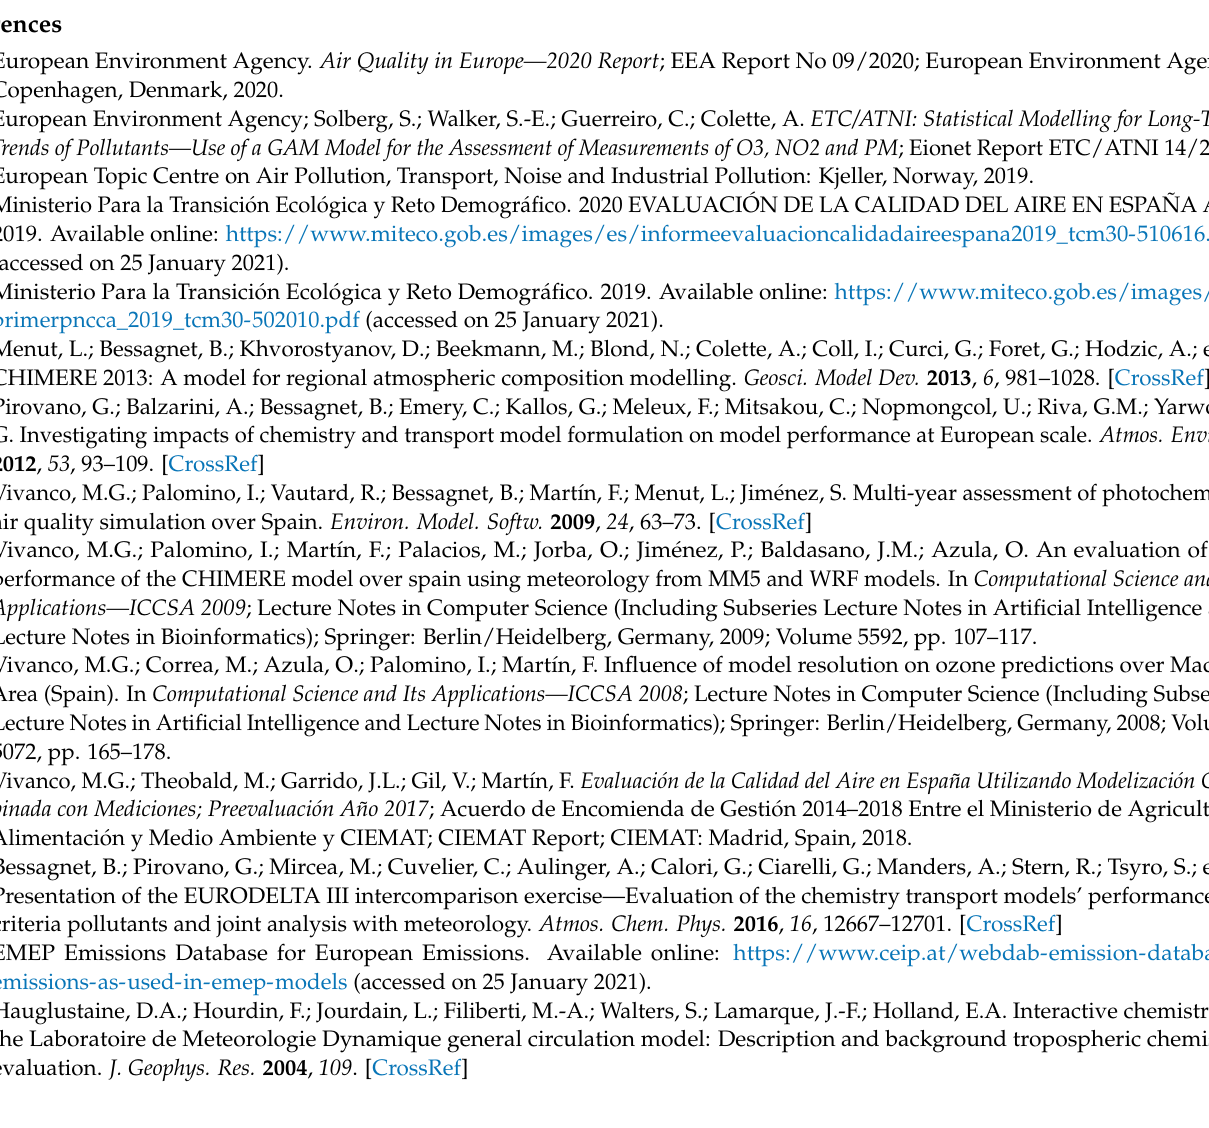
Figure A6. Mean monthly differences (µg m −3 ) between the WAM2030 scenario and 2016 in January and July.